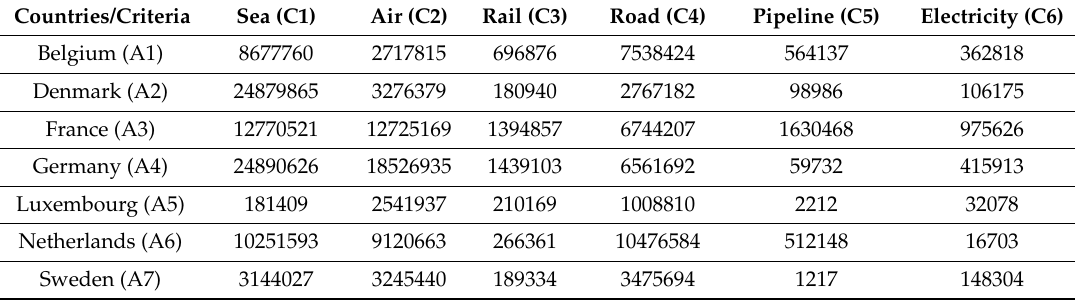
Table 4. Selected Data of Transport Export for the EU by 2016 (US Dollar, Thousand).